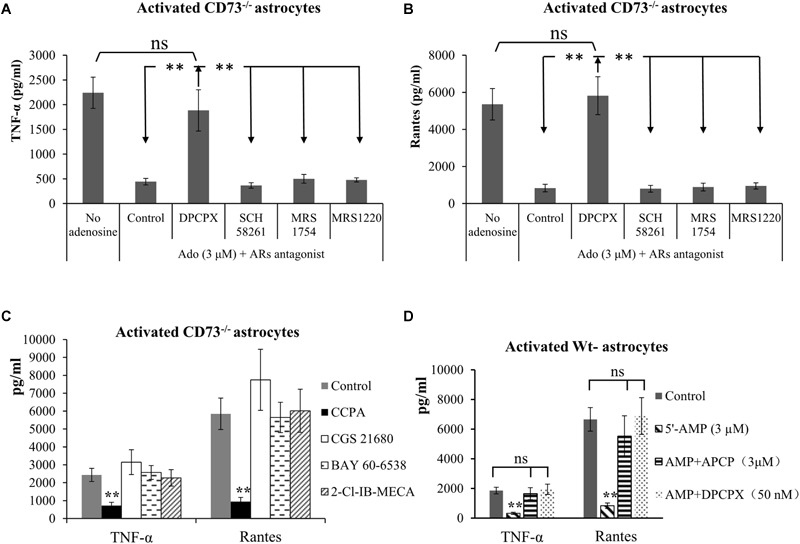
The effects of AMP, adenosine, selective ARs agonists or antagonists on wt- and CD73-/- astrocytes. Wt- and CD73-/- astrocytes were activated with LPS (100 ng/ml) plus IL-1β (10 ng/ml), with or without the addition of 5′-AMP (3 μM), adenosine (300 nM), selective ARA1 agonist/antagonist: CCPA (50 nM)/DPCPX (50 nM), selective ARA2A agonist/antagonist: CGS 21680 (259 nM)/SCH 58261 (100 nM), selective ARA2B agonist/antagonist: BAY 60-6538 (100 nM)/MRS 1754 (100 nM) and selective ARA3 agonist/antagonist: 2-Cl-IB-MECA (100 nM)/MRS1220 (5 μM). Culture medium was collected 2 days later, and RANTES and TNF-α levels in the supernatant were detected by ELISA. TNF-α (A) and Rantes (B) in the medium of activated CD73-/- astrocytes treated with adenosine(Ado) and ARs antagonists or ARs agonists (C). (D) TNF-α and Rantes in the medium of activated Wt-astrocytes treated with AMP, CD73 inhibitor and ARA1 antagonist. ∗∗Indicates statistically significant differences (p < 0.01). ns: no significance.